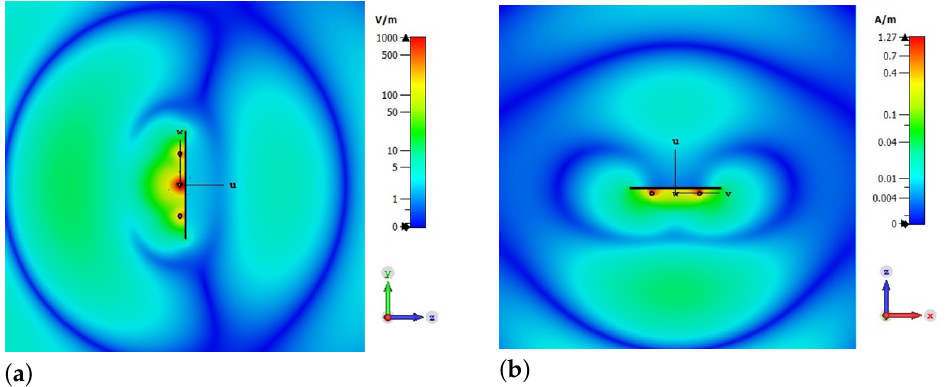
Figure 2. Field distribution E-field ( a ) and H-field ( b ) near a unidirectional